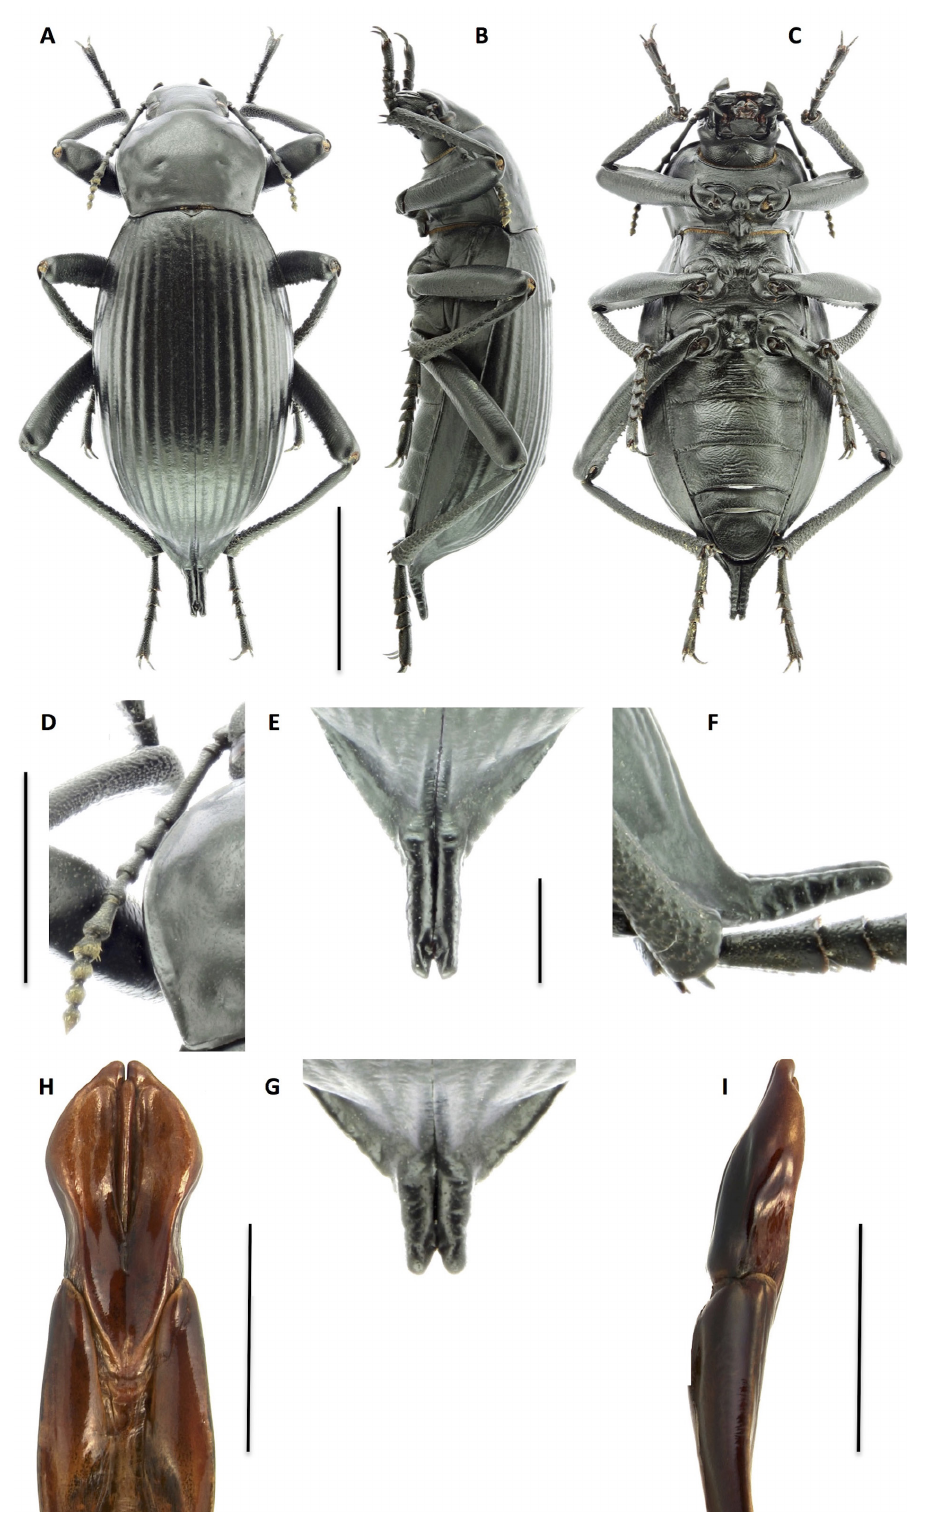
Fig. 1. Blaps effeminata Soldati sp. nov. A . ♂, habitus (dorsal view). B . ♂, habitus (lateral view). C . ♂, habitus (ventral view). D . ♂, left antenna (dorsal view). E . ♂, mucro (dorsal view). F . ♂, mucro (lateral view). G . ♀, mucro (dorsal view). H . ♂, aedeagus (ventral view). I . ♂, aedeagus (lateral view). Scale bars: A–C = 10 mm; D = 5 mm; E–G = 2 mm; H–I = 3